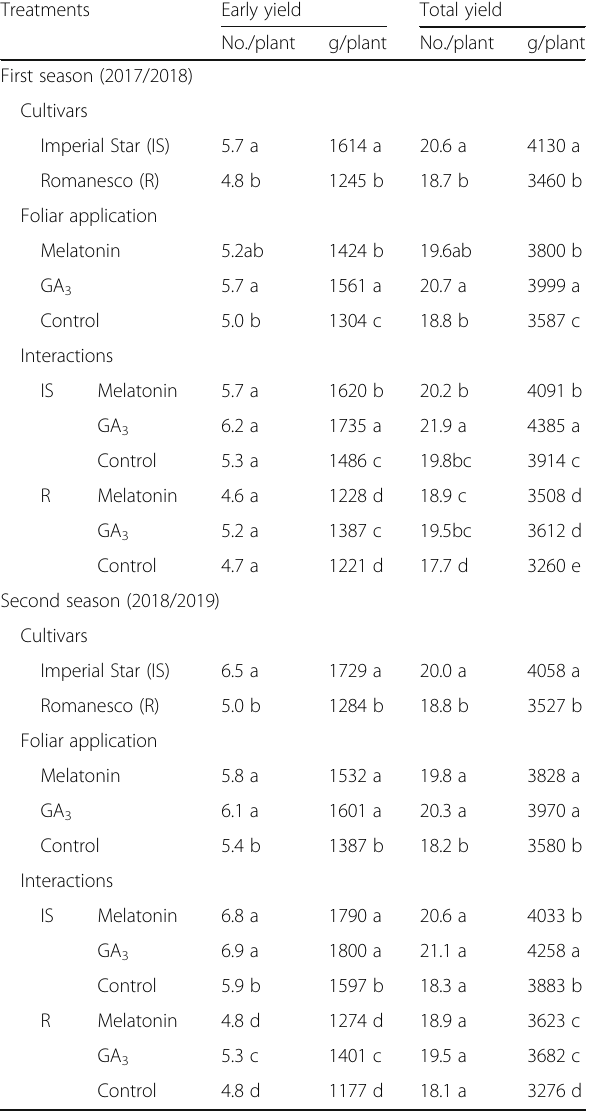
Table 3 Effect of GA 3 and melatonin on head yield of two artichoke cultivars during the two growing seasons of 2017/ 2018 and